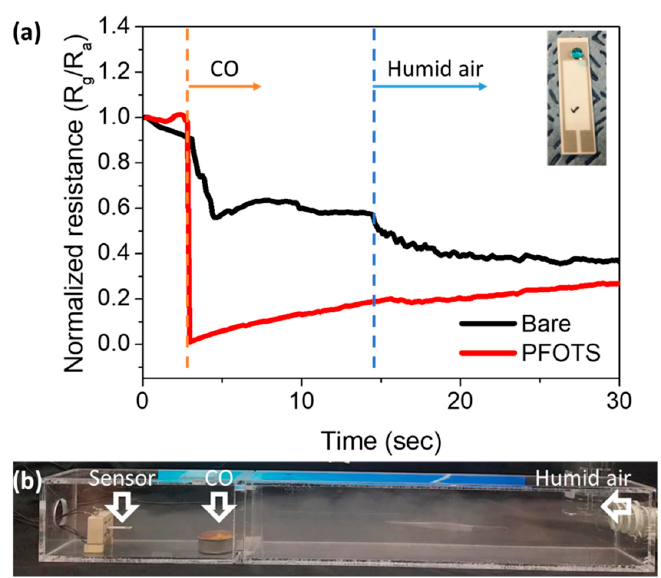
Figure 6. ( a ) The response of bare and PFOTS coated gas sensors in real conditions using a candle flame under humid conditions from a commercial humidifier in an acrylic box and ( b ) the experimen- tal set-up for CO detection from candle flame under humid environment. The resistance of reaction gas is R g , and for dry air is R a